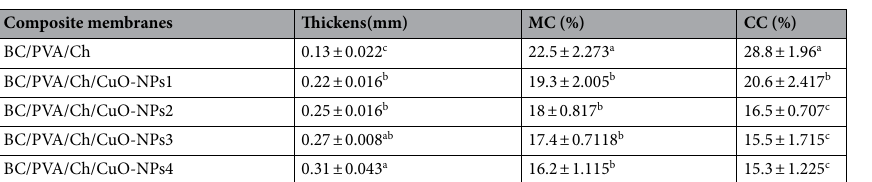
Table 2. Physicochemical characterization of BC/PVA/Ch/CuO-NPs composite membranes including: thickness, moisture content (MC) and composite content (CC) of BC/PVA/Ch at different CuO-NPs concentrations. All values were expressed as Mean ± standard deviation. Different letters are significantly different in ascending order where a > b > c > d > e within the same column at p < 0.05.